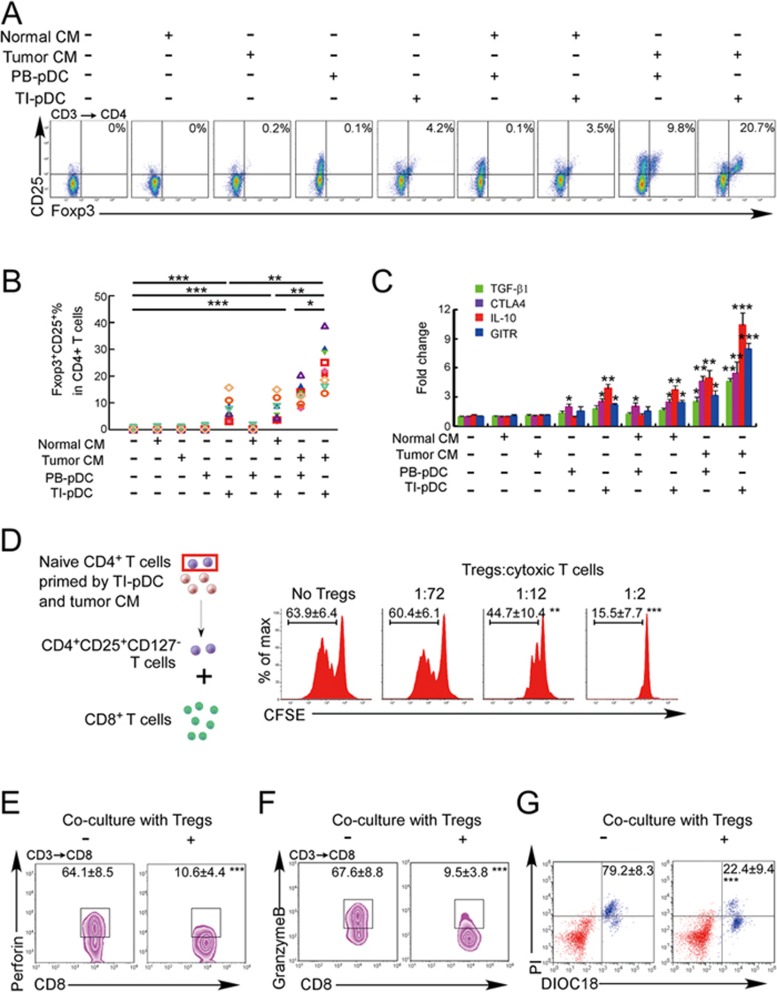
Naive CD4+ T cells are converted to functional Tregs by tumor-infiltrating DCs and tumor conditioned medium (CM). (A-C) Naive CD4+ T cells from peripheral blood of patients with invasive breast carcinoma were co-cultured with or without autologous pDCs isolated from tumor (TI) or peripheral blood (PB) for 9 days in the presence or absence of 30% CM from autologous tumor slices or adjacent normal tissue slices. (A, B) Non-adherent cells from co-cultures were stained for CD3, CD4, CD25 and intracellular Foxp3, and analyzed by flow cytometry. Representative plots of gated CD3+CD4+ cells (A) and quantification of percentage of Foxp3+CD25+ cells among CD3+CD4+ cells (B) are shown (mean ± SEM, n = 19; *P < 0.05, **P < 0.01,***P < 0.001 by Student's t-test). (C) Expression of Treg-associated genes, assessed by qRT-PCR normalized to GAPDH, in sorted CD4+ T cells, relative to expression in cultures without DCs or CM (mean ± SEM, n = 19; *P < 0.05, **P < 0.01,***P < 0.001 compared with naive CD4+ T cells cultured alone by Student's t-test). (D-G) Effect of naive CD4+ T cell-derived Tregs, obtained by co-culture with TI pDCs and tumor CM as above, on function of autologous tumor-specific CD8+ T cells. Tumor-specific CD8+ T cells were generated for each subject by stimulating autologous PB CD8+ T cells with autologous tumor lysate-pulsed autologous DCs. Tregs were recovered from co-cultures by magnetic sorting. (D) CFSE-labeled CD8+ T cells were incubated with tumor lysate-pulsed DCs in the presence of induced Tregs at the indicated ratios and proliferation was assessed by flow cytometry. Numbers denote the percentage of cells undergoing at least one cellular division (mean ± SEM, n = 12, **P < 0.01, ***P < 0.001 compared with CD8+ T cells cultured without Tregs). (E-G) Tumor-specific CD8+ T cells were incubated with autologous primary breast cancer cells for 18 h in the presence or absence of Tregs (CD8:Treg 2:1) and stained for CD3, CD8, intracellular perforin (E) or granzyme B (F) and gated CD3+CD8+ cells were analyzed by flow cytometry. Numbers indicate the percentage of gated cells stained for perforin or granzyme B (mean ± SEM, n = 7; ***P < 0.001 compared with CD8+ T cells cultured without Tregs). (G) Tumor-specific CD8+ T cells were incubated with autologous dioctadecyloxacarbocyanine (DIOC18)-labeled primary breast cancer cells for 18 h in the presence or absence of Tregs (CD8:Treg 2:1) and the death of tumor cells was assessed by propidium iodide (PI) uptake by flow cytometry. The numbers shown indicate the percentage of PI+ tumor cells (mean ± SEM, n = 4; ***P < 0.001 compared with CD8+ T cells cultured without Tregs).